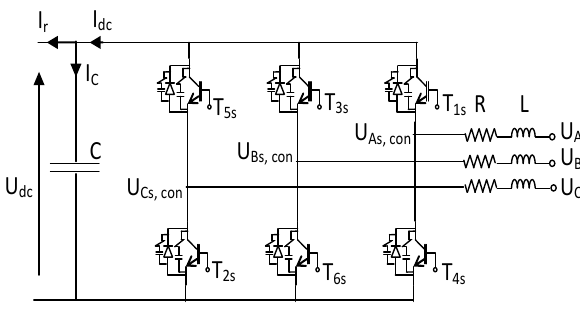
Figure 5. Grid side voltage source converter.